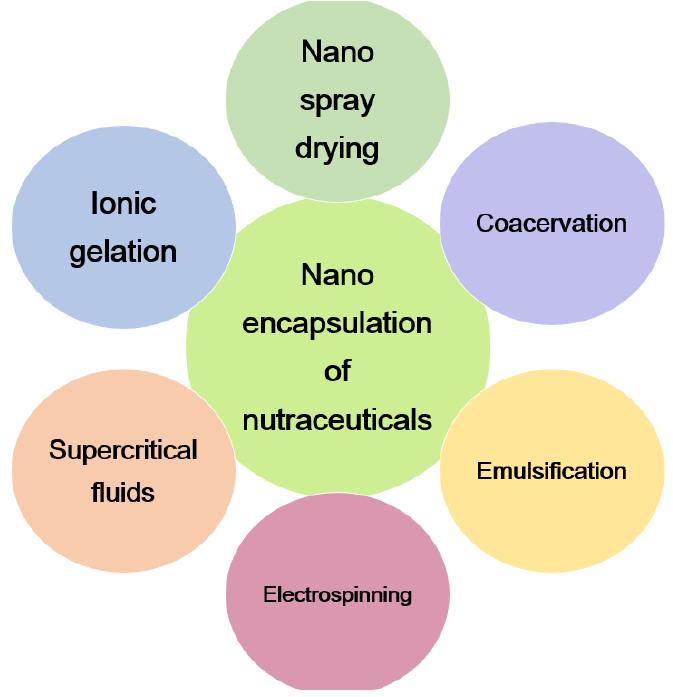
Figure 7. Nanoencapsulation of nutraceuticals with chitosan and its derivatives.